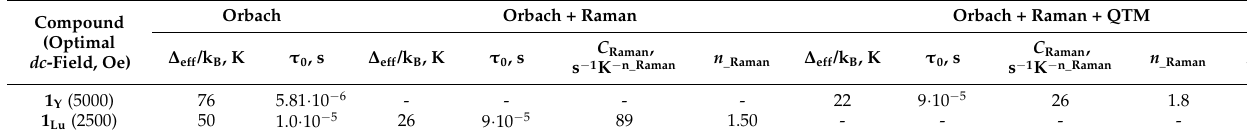
Table 3. The best-fit parameters of magnetization relaxation for 1 Y and 1 Lu .